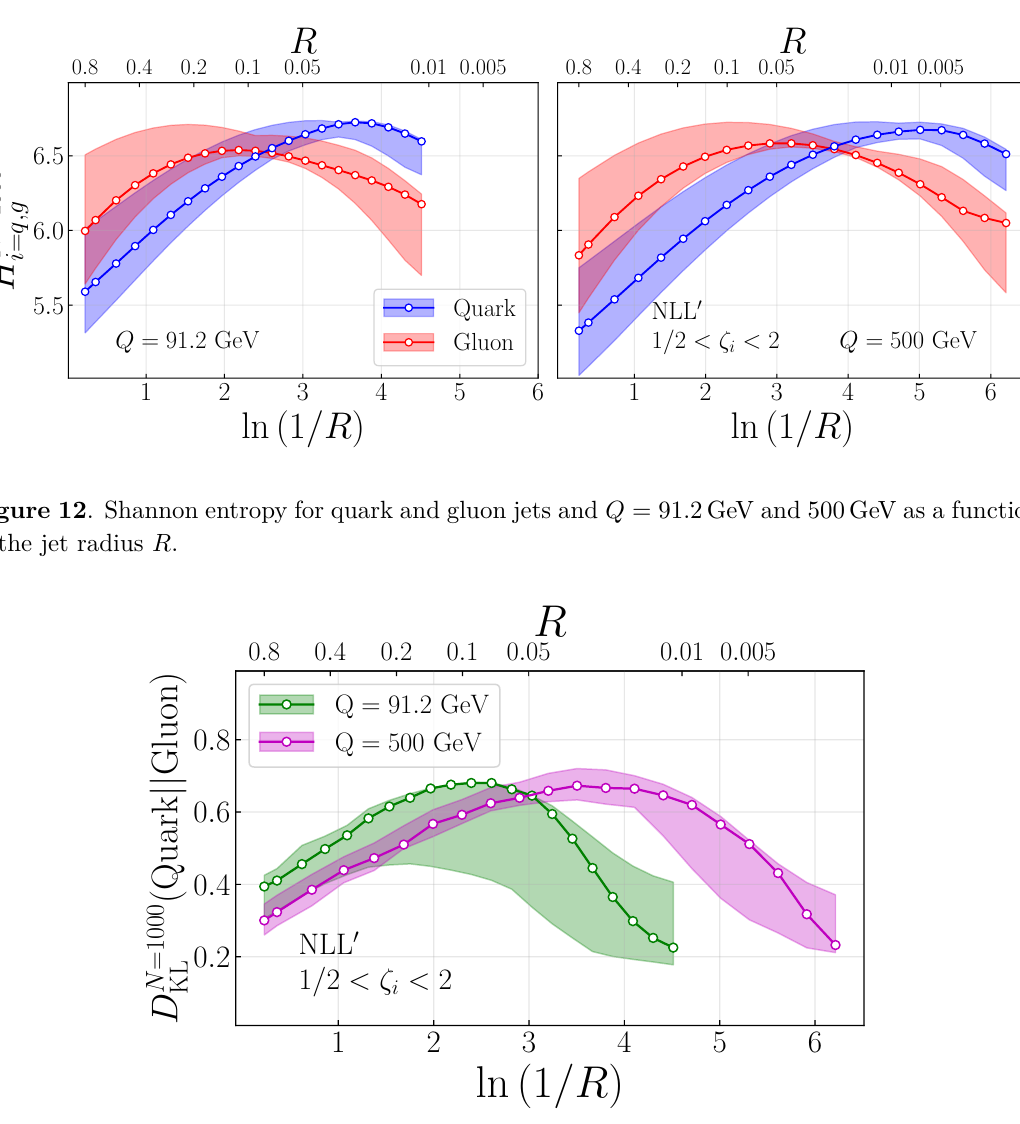
Figure 13 . KL divergence of the leading jet distributions as defined in eq. (5.17) which quantifies the difference between the quark and gluon leading jet energy